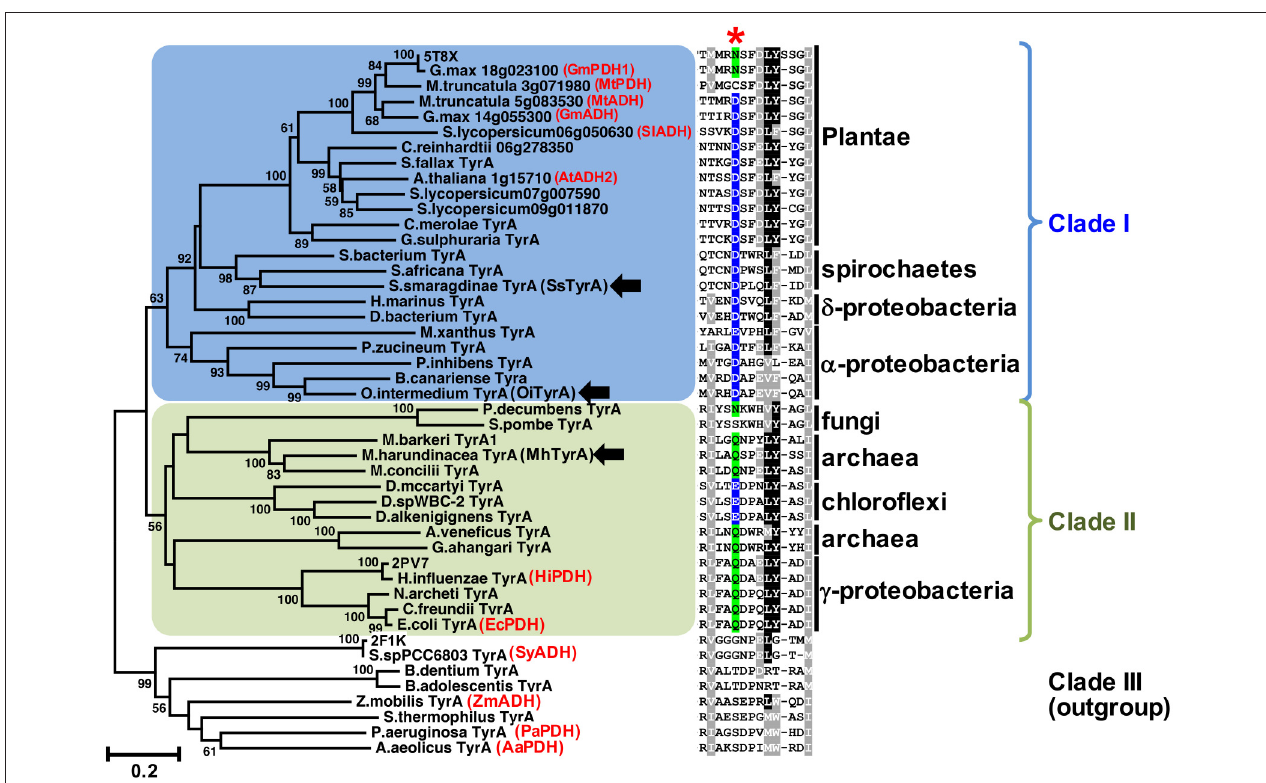
FIGURE 2 | The conserved acidic residue at 222 among clade I TyrA orthologs from plants, algae, and closely-related bacteria. Structure-guided phylogenetic analysis of plant and microbial TyrAs. Three distinct clades are formed; clade I contains all plant TyrAs and closely-related microbes (blue), clade II contains bacteria, archaea, and fungi TyrAs (green), and clade III, which was used as an outgroup. Enzymes characterized in this study are marked by black arrows. Structures used to guide the alignment are labeled with their PDB IDs. Previously characterized TyrAs are labeled in red with their preferred PDH or ADH activity. Scale bar represents number of substitutions per branch length. A trimmed amino acid alignment of corresponding sequences shows a conserved acidic residue (Asp or Glu, highlighted in blue) among clade I, which is replaced with a non-acidic Asn or Gln residue (highlighted in green) in most clade II at the corresponding 222 position marked with a red star. Identical amino acids present in > 50%, black shading; biochemically similar residues present in > 50% of the sequences, gray